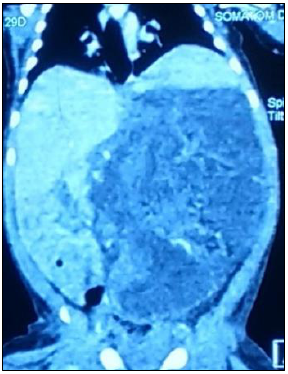
Figure 1: CECT abdomen revealed a large relatively well- defined heterogeneously enhancing mass lesion involving the entire left half of abdomen with